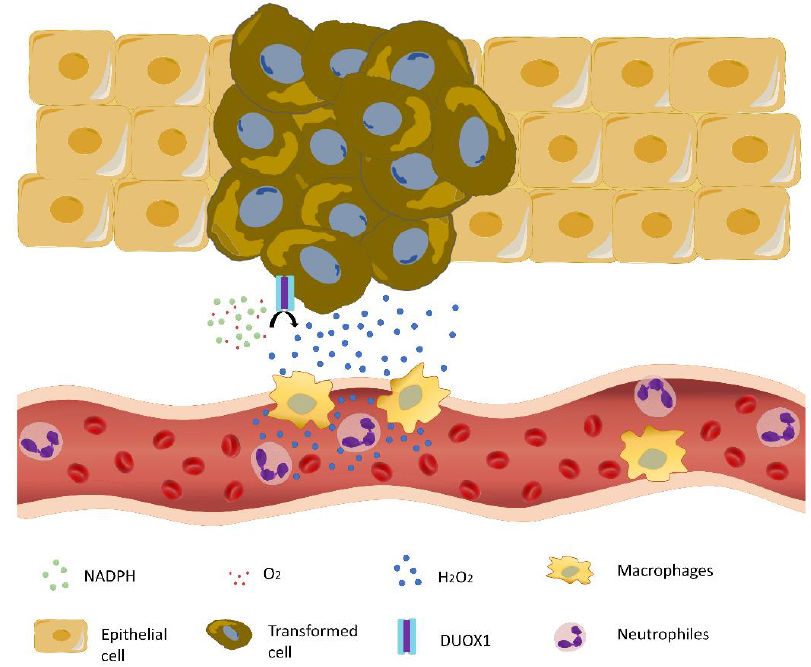
Figure 3. DUOX1-derived hydrogen peroxide from transformed cells and their neighboring cells attracts immune cells facilitating tumor growth.